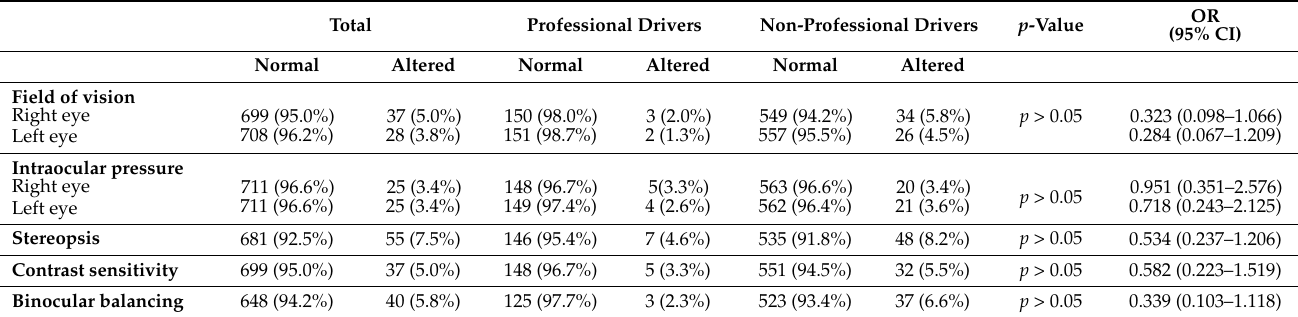
Table 3. Visual screening